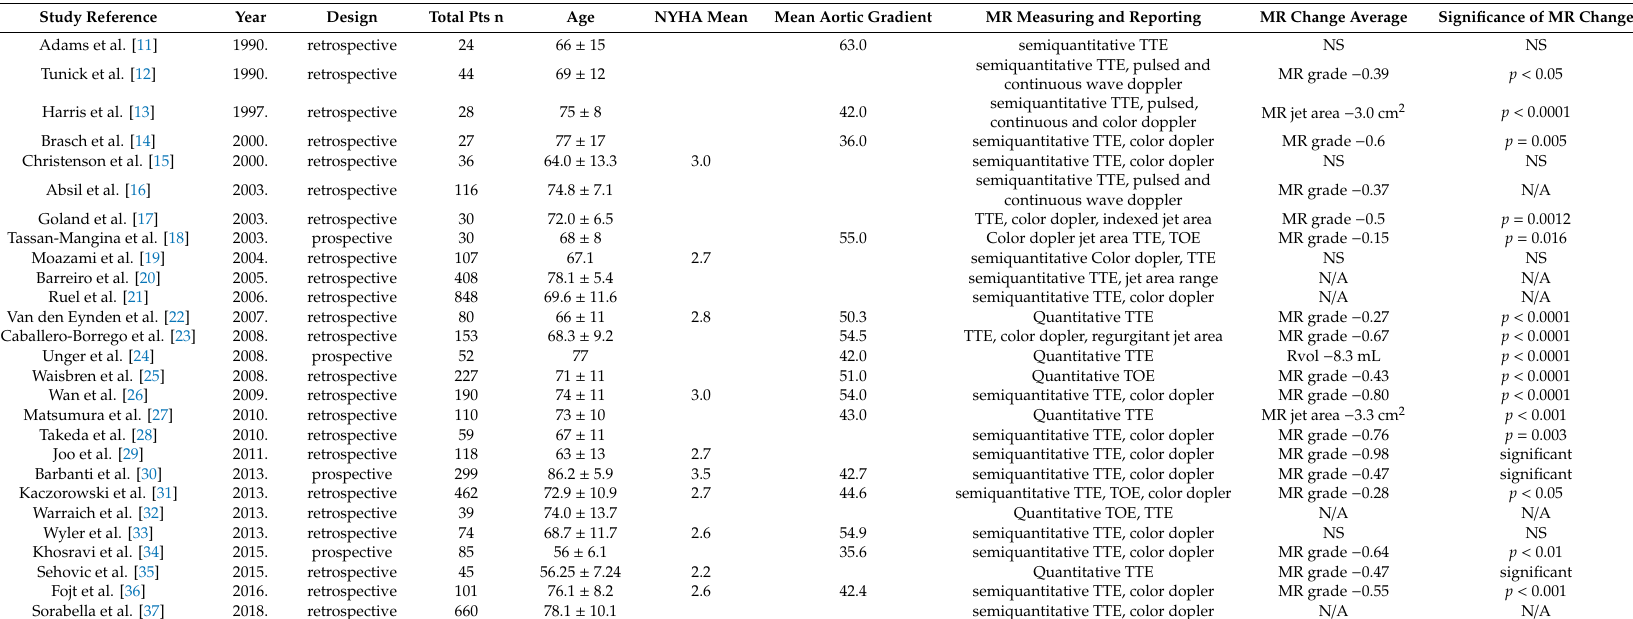
Table 1. Characteristics of studies included in the